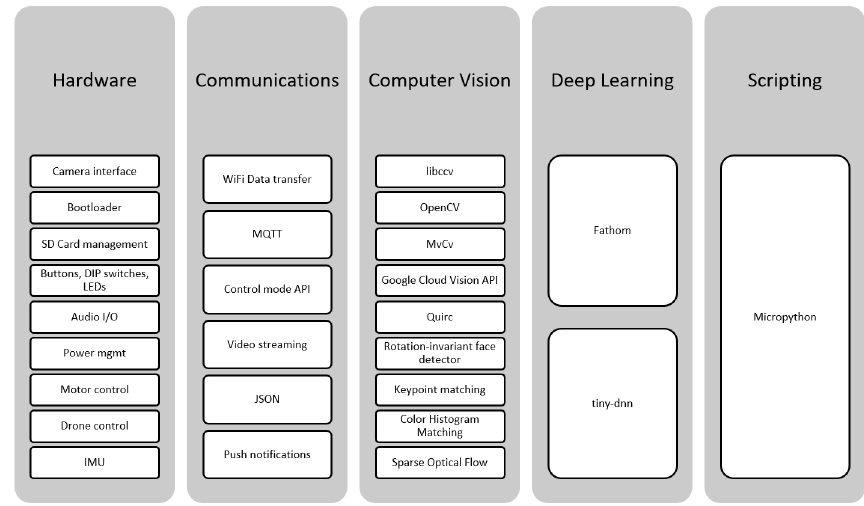
Figure 9. Main EoT software modules.